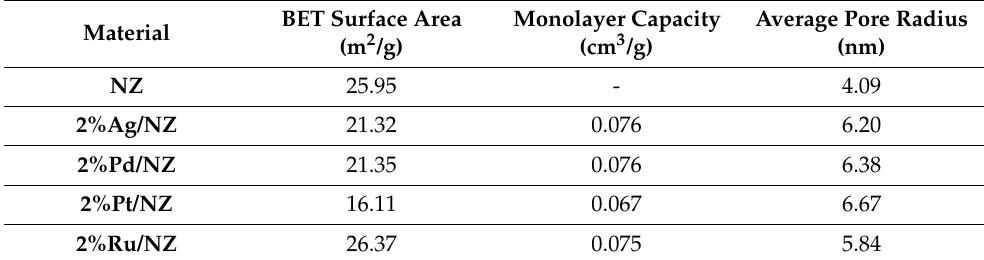
Table 3. The specific surface area measurements calculated for the synthesized catalytic materials calcined at 400 ◦ C for 4 h in an air